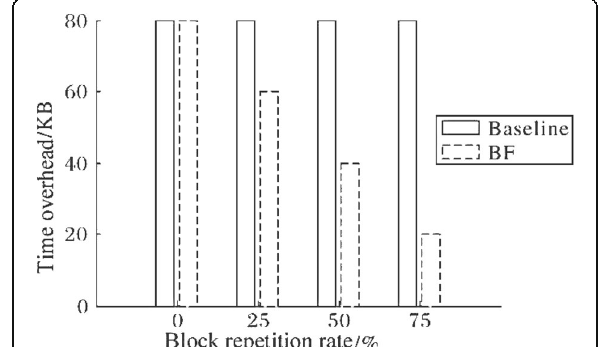
Fig. 8 Time cost of cryptographic convergence secret key. : It represents the time overhead of the baseline scheme to encrypt the key.